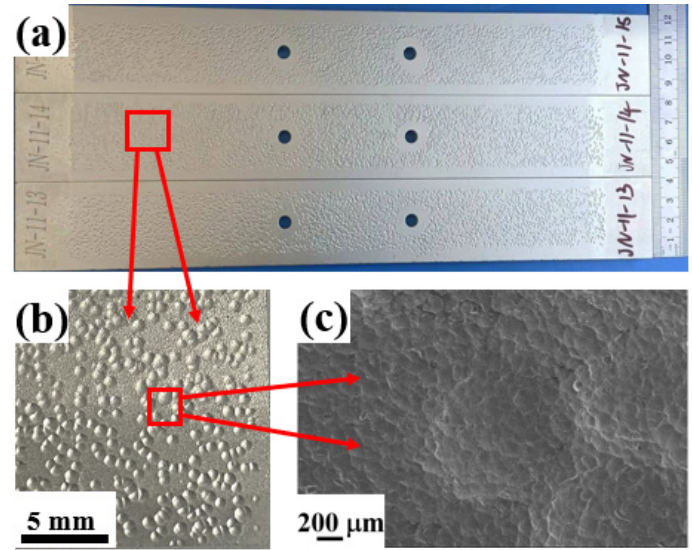
Figure 2. Diagram of FPA sample wall panel and its surface crater: ( a ) Corrosion fatigue specimens; ( b ) craters left after shot peening; ( c ) scanning morphology of craters.